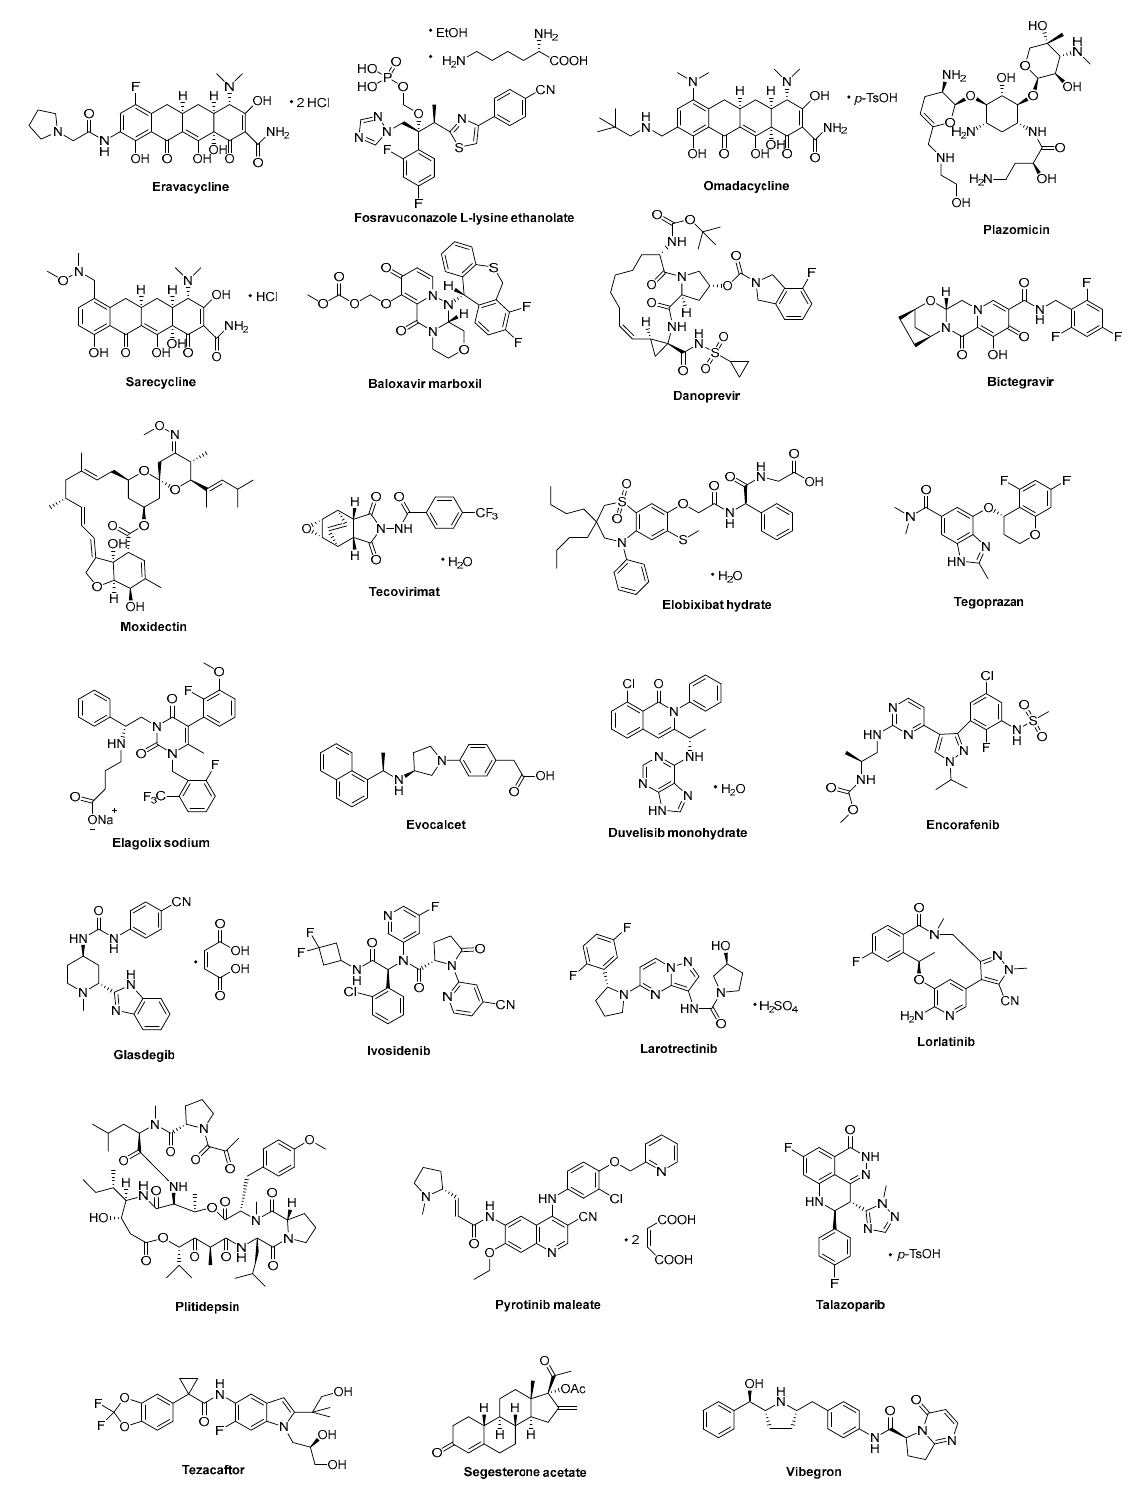
Figure 4. Structure of chiral drugs approved in 2018.